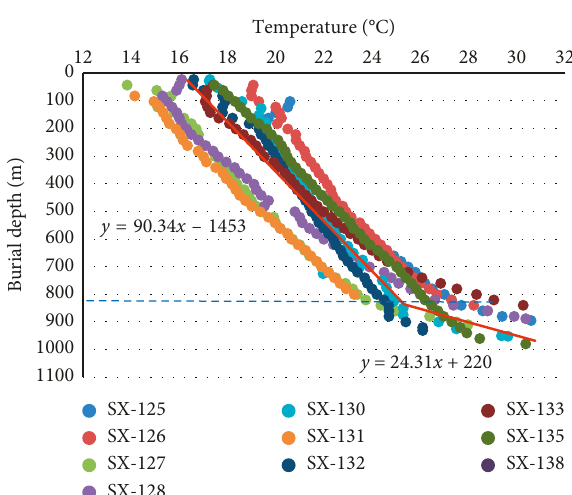
Figure 8: Relational graph of temperature and burial depth in Qinshui